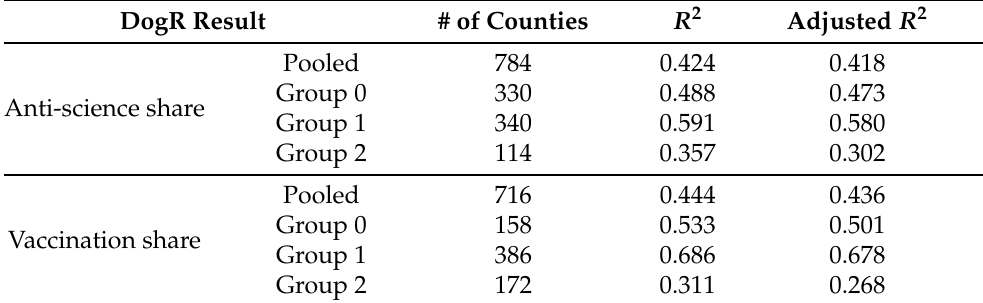
Table 3. Goodness-of-fit measures for regression in pooled data containing all counties and for the subgroups of counties discovered by